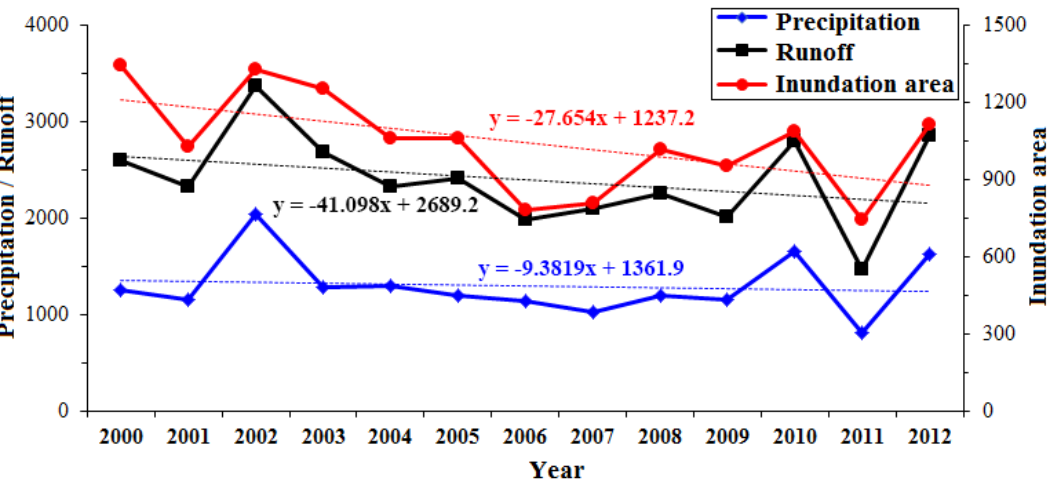
Figure 4. Temporal changes in annual precipitation, runoff and inundation areas acquired from MODIS data during 2000 to 2012 in the Dongting Lake. The dotted lines denote their development trends. (Precipitation: mm; Runoff: 10 8 m 3 ; Inundation area: km 2 ).